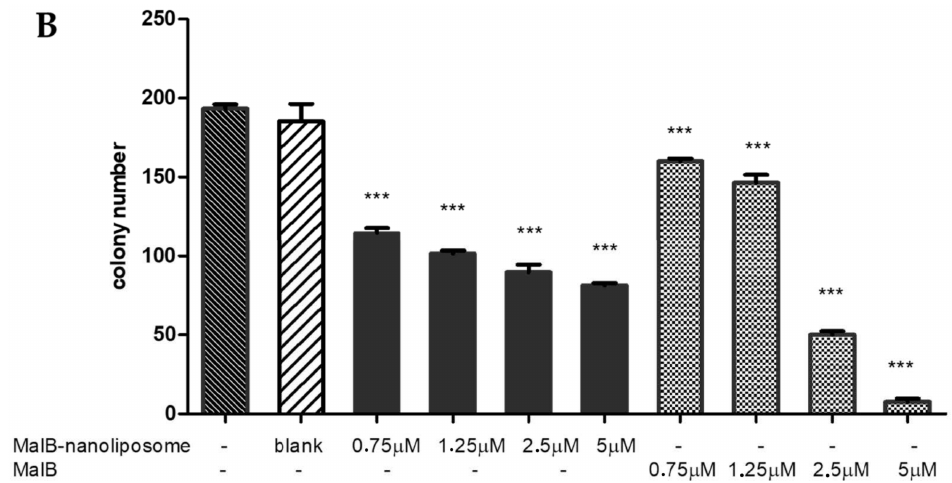
Figure 3. Antitumorigenic activity of malB-nanoliposome and free compound on A549 cells. ( A ) Colony images after treatment of malB-nanoliposome and free-compound at di ff erent concentrations compared to the negative control (normal saline) and blank liposome on day 8. ( B ) Colony number after treated with blank nanoliposome, malB-nanoliposome, and malB compared to the negative control. Each value represents the mean ± SEM. *** p < 0.001.